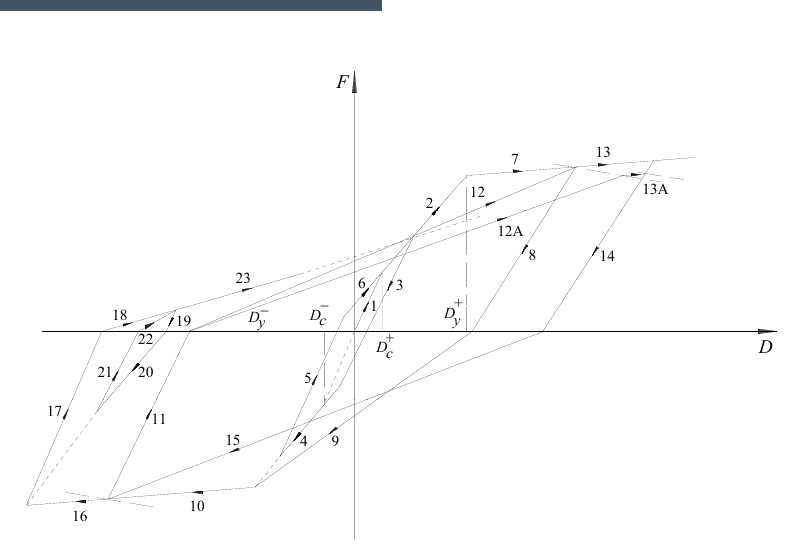
Figure 2. Bending hysteretic model for RC elements